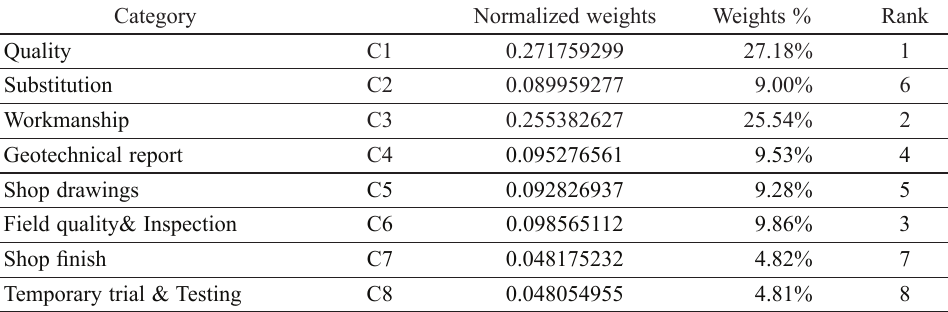
Table 7. Normalized weights of PCM and Ranking of clause category